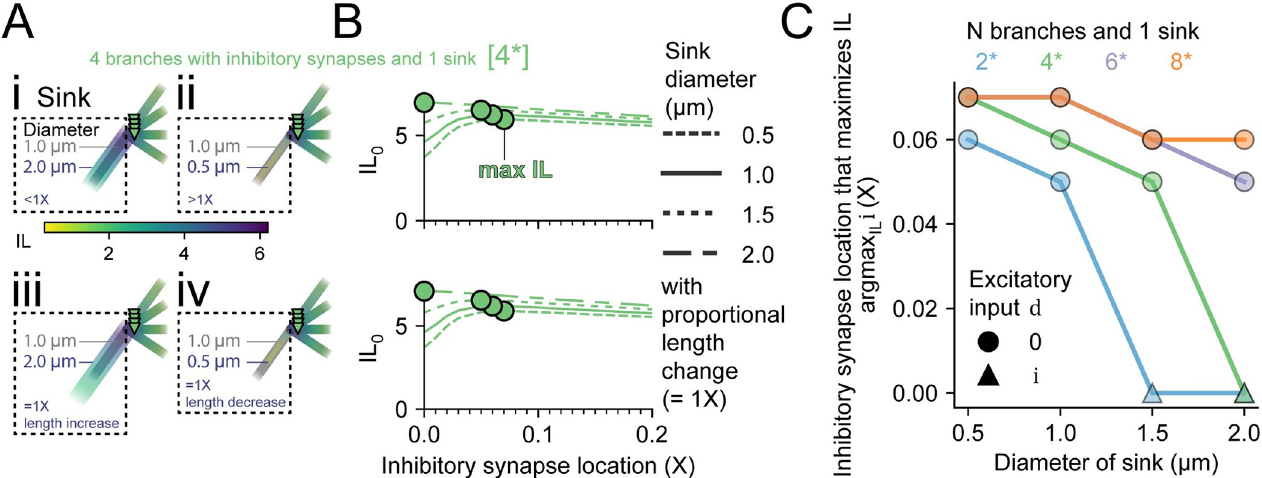
Fig 8. The optimal placement of inhibitory synapses depends on the diameter of a parent branch, which creates a chloride sink. A large chloride “sink” means that the inhibitory synapse location that maximises IL (argmax IL i) moves closer to the shared branch junction. (A) A parent branch (a “sink”) attached to a further 4 branches each with an inhibitory synapse (i = 0.2 X). The size of the parent branch was changed by altering the diammeter from 1 μ m (black shade) whilst keeping the length the same, which changes the length constant ( < 1 X, Ai and > 1 X, Aii) or by changing the diameter and length proportionally which maintained the length constant (= 1 X, Aiii and Aiv). The panels Ai-iv use a shared heatmap with the lowest and highest IL across all of them. (B) Doubling the sink diameter from 1 μ m (solid line) to 2 μ m (alternating long dash then short dash) noticeably changed the IL at the junction (IL 0 ) values and moved the max IL (circle marker per diameter) closer to the junction (0.00 X). Halving the sink diameter to 0.5 μ m (thinner dashed line) slightly shifted the IL 0 trace and max IL was 0.07 X. This pattern, and IL values, were very similar when the parent branch length was changed in porpotion to the diammeter (bottom)). (C) Summary panel indicating the effect of sink diameter on the optimal placement of inhibitory synapses for different branch (and synapse) numbers, each having a single sink. Sinks of a larger diameter were more influential in ameliorating chloride-related deterioration in inhibitory efficacy but this amelioration was dampened for more branches. The location of excitatory input d to elicit the maximum IL is indicated by a circle (junction) or triangle (inhibitory synapse location).